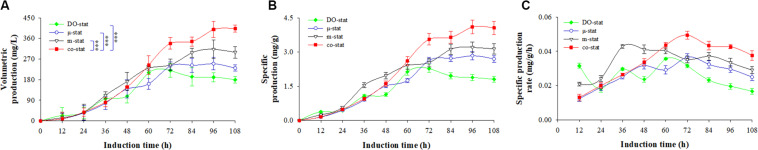
FBG1 production in response to different induction strategies. (A) Volumetric production (mg/L). (B) specific production (mg/g). (C) specific production rate (mg/g/h). Time zero indicates the initiation of methanol addition. DO-stat strategy (filled green diamond), μ-stat strategy (open blue circle), m-stat strategy (open black triangle), co-stat (filled red square). Asterisk indicates the two-group have significant difference (∗∗∗P < 0.001).